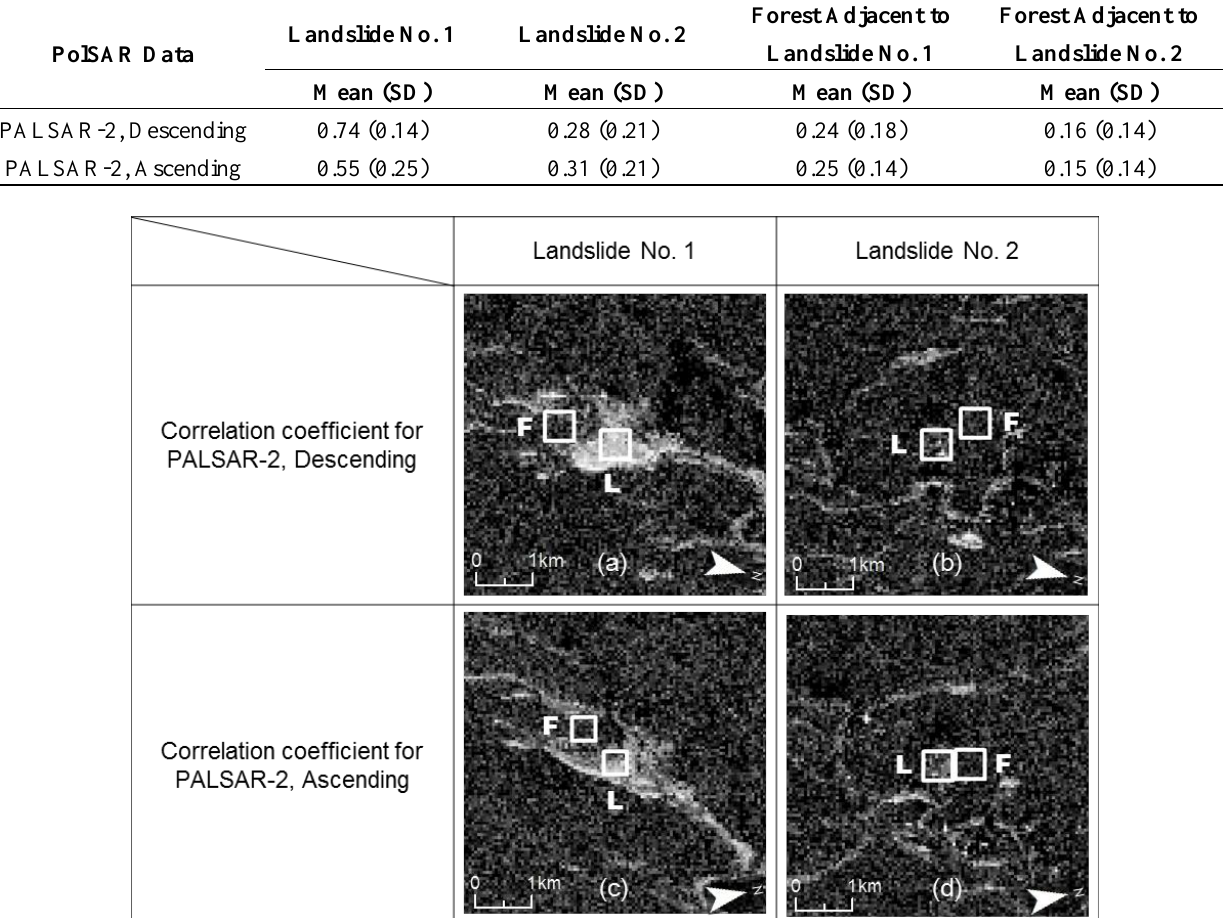
Figure 7. The HH-VV correlation coefficient Re ( γ ( θ ) HH - VV ) images for PALSAR-2 data in ( a , b ) descending and ( c , d ) ascending orbit observations. The correlation coefficient values for landslides (L) and those of neighboring forest (F) were sampled in the white rectangles on the